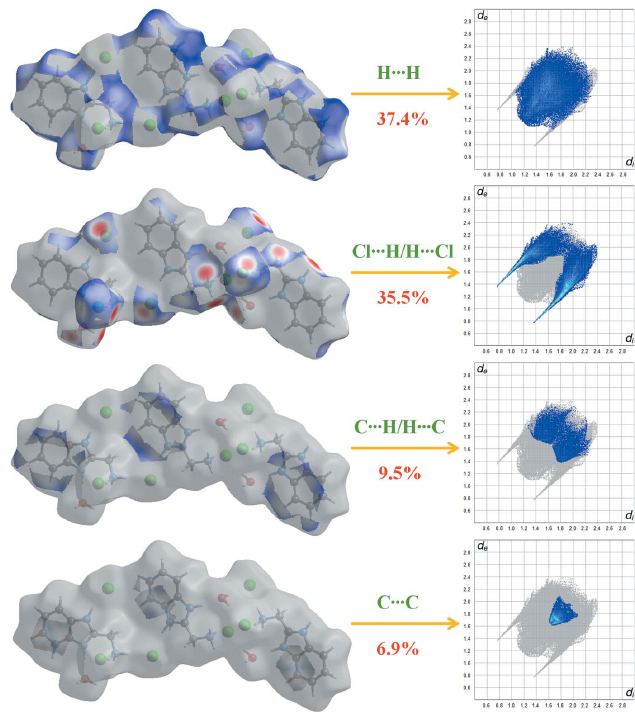
Figure 6 Two-dimensional fingerprint plots with a d norm view of the H (cid:2)(cid:2)(cid:2) H